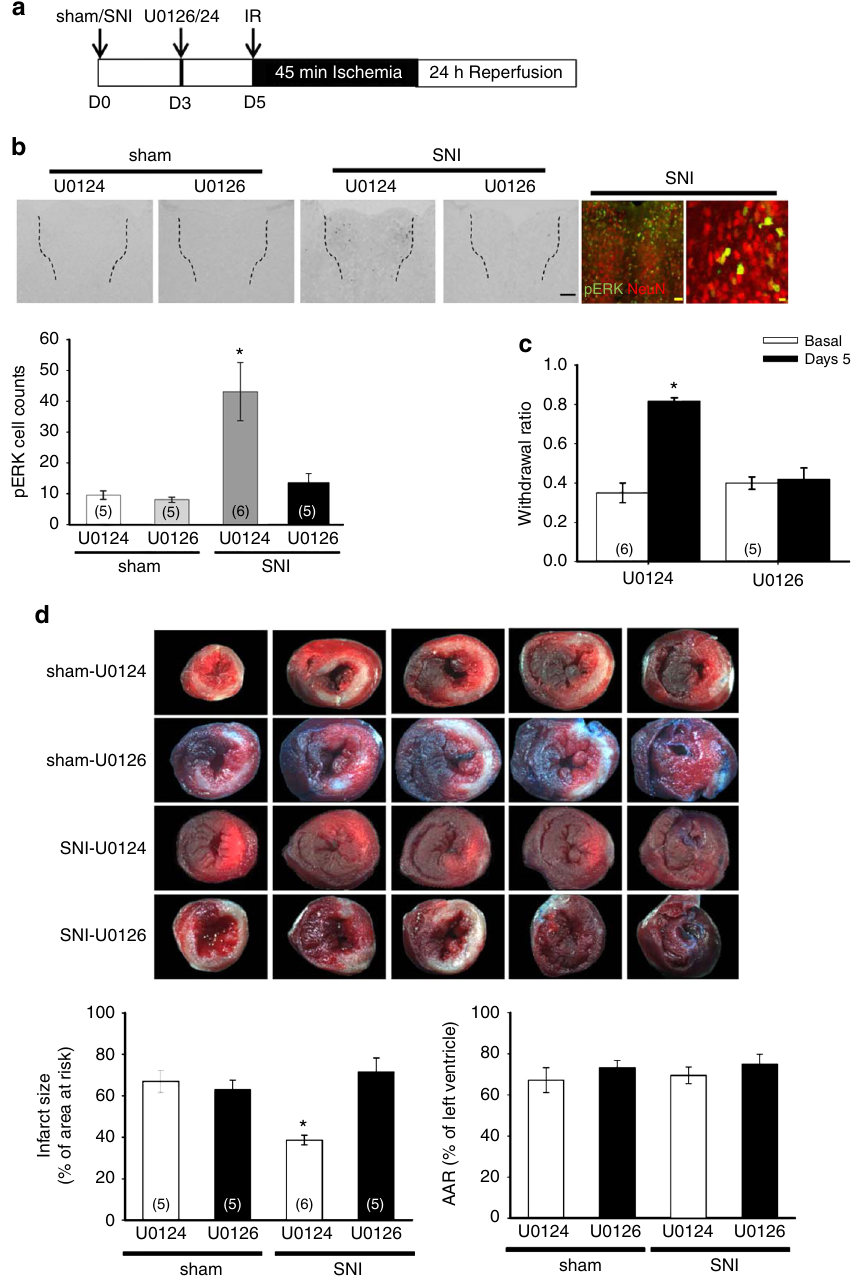
Fig. 3 Infusion of U0126 but not U0124 in PVA blocks the SNI-induced cardioprotection. a Schematic of experimental design showing the timeline for sham/SNI surgery (D0), intra-PVA infusion of U0126/or U0124 (1.5 mM in 0.3 μ L 50% DMSO, D3) and myocardial IR surgery (D5). b Immunohistochemical staining of pERK, an indication of ERK activation, in PVA (outlined by dashed line ) from sham and SNI animals received U0126 or U0124 infusion. Scale bar = 100 μ m. Immuno fl uorescent imaging of pERK ( green ) and NeuN ( red ) in PVA from SNI animal. Scale bar = 50 μ m (lower magni fi cation) and 10 μ m (higher magni fi cation), respectively. Quanti fi cation results of pERK-positive cells in PVA from these animals. c Mechanical responses of hind paws at D0 (basal) and D5, after intra-PVA infusion of U0124 or U0126 (D3). * p < 0.05 vs. basal group. d Representative images of TTC staining in heart cross-sections. Quanti fi cation results of infarct size and AAR in cardiac sections from U0124 and U0126-infused animals ( middle and lower panels ). Infusion of U0126 prevented the SNI-induced cardioprotection. ** p < 0.001 vs. U0124 group. Error bars indicate SEM. Statistical signi fi cance was determined by one-way ANOVA ( b , d ) or two-way RM ANOVA ( c